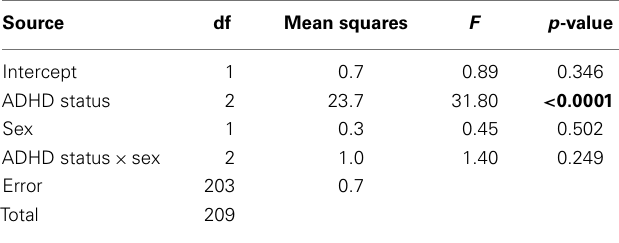
Table 2 | Summary statistics for the 3 × 2ANOVA with the personality-risk factor score as the dependent variable .